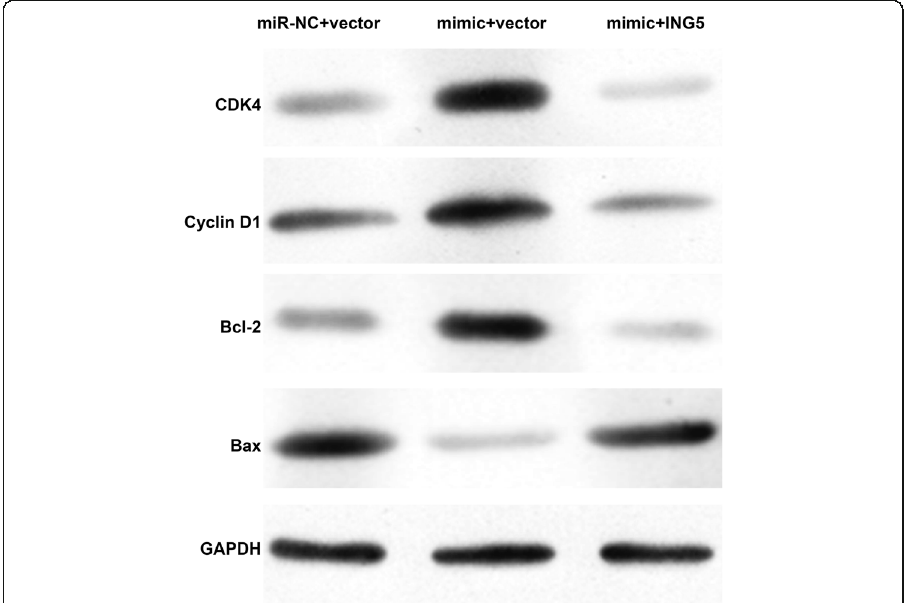
Fig. 6 Restoration of ING5 expression alleviated the effect of miR-376c-3p overexpression on cell cycle arrest- and apoptosis-associated factors. PC-12 cells were co-transfected with pcDNA3.1/ING5 vector and miR-376c-3p mimic and then subjected to OGD. Western blot analysis was performed to measure the protein expressions of CDK4, cyclin D1, Bcl-2 and Bax. GAPDH was used as an internal